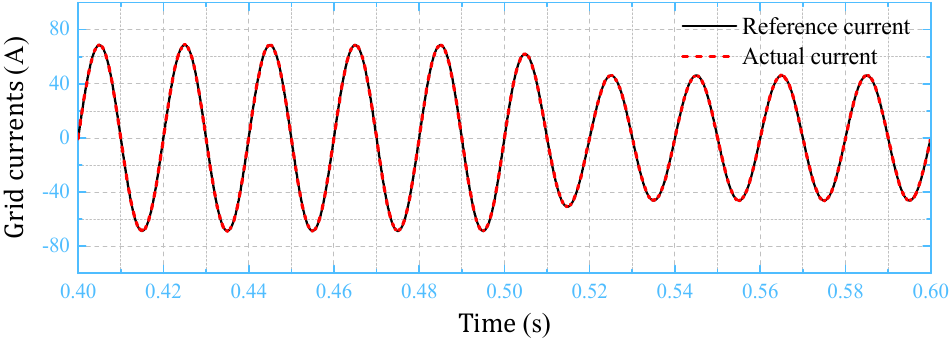
Figure 10. The reference and actual injected currents of the seven-level inverter at irradiance variation.